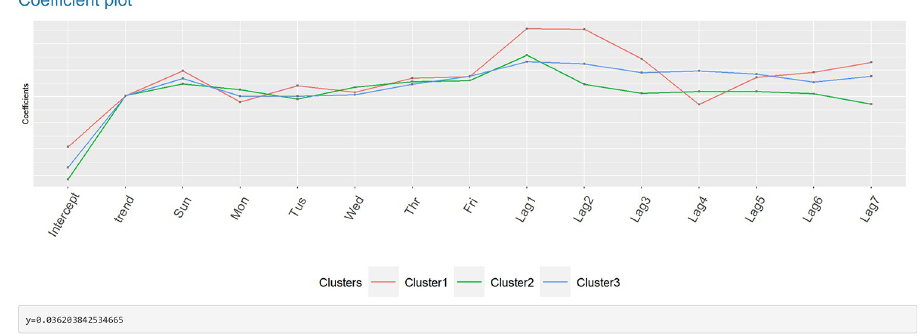
Fig 4. Clustering and forecasting Taiwan COVID-19 confirmed infection cases—Part 4.